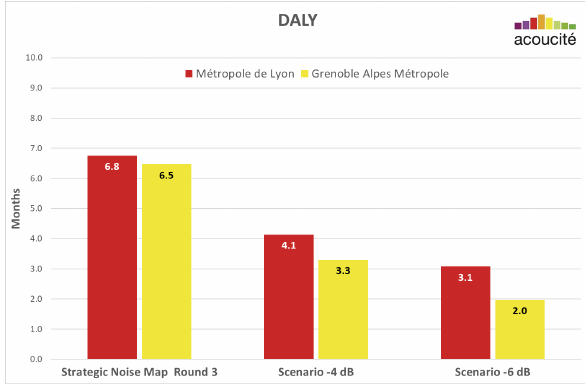
Figure 11: Estimated variations in Disability Adjusted Life Year due to road noise within the metropolises of Lyon and Grenoble for two road noise reduction scenarios corresponding to what was observed during the lockdown period